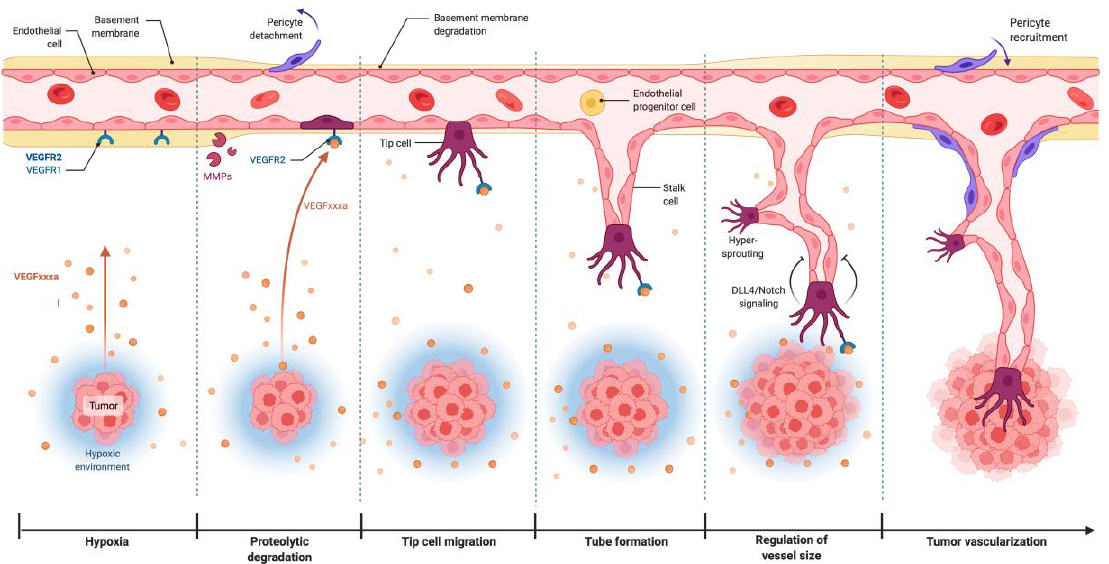
Figure 2. Tumor cells secrete VEGF xxxa , which initiates a series of steps that culminate in increased angiogenesis. Image was created using BioRender (2022).